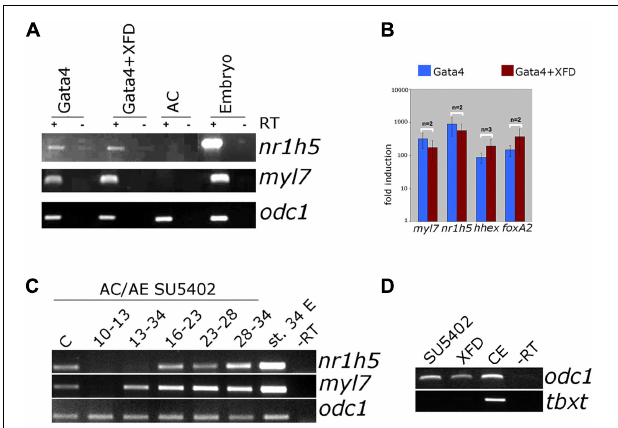
FIGURE 7 | FGF signaling is not required for liver specification by Gata4 but is essential in AC/AE explants. (A) Gata4 and XFD (dominant-negative FGFR1) mRNA co-expression in animal pole explants has no effect on nr1h5 and myl7 expression. (B) qPCR analysis confirms these findings and extends them by showing no significant effect on hhex and foxa2 . (C) Treatment of AC/AE with FGFR inhibitor SU5402 (50 µ M) has stage-specific effect. Immediately upon AC/AE conjugate formation, SU5402 inhibits cardiac and liver gene expression. Treatment from st. 13 until the end of incubation at st. 34 has no effect on cardiogenesis but inhibits liver specification. Shorter time windows of treatment are largely without effect. Staging is according to the stage of AE (st. 10 at the time of conjugation). C-Control explants treated with 50 µ M DMSO. (D) SU5402 and XFD are effective inhibitors of early mesodermal marker and FGF target gene tbxt . CE-control (untreated) sibling embryos. RT-PCR analyses were performed on st. 34 explants and sibling embryo